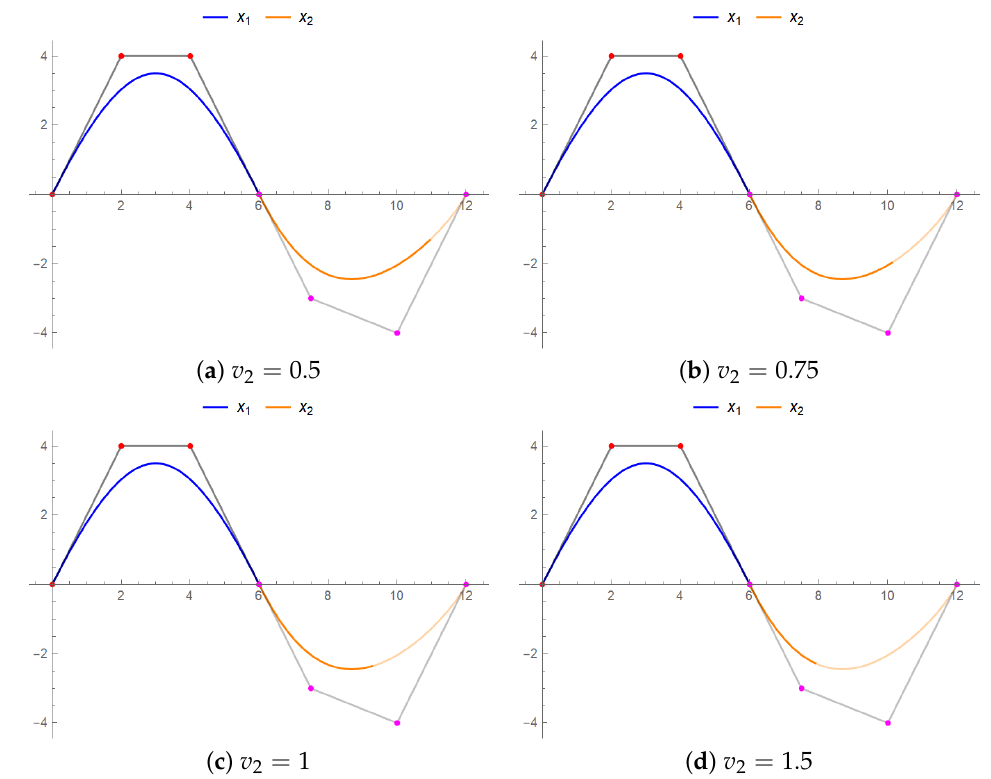
Figure 11. G 1 continuity of two connected cubic fractional Bézier curves. Example 7. The cubic fractional Bézier curves with variations of fractional parameter satisfying the G 2 continuity conditions at their joints is shown in Figure 12. The control points for x 2 is the same as in Example 6. By using Theorem 4, the control points of R 0 , R 1 and R 2 can be obtained. The last control point, R 3 = ( 6, − 12 ) , is set. α = 0.75 and β = 0.5 are the scalar factors, where α > 0 and β ∈ R